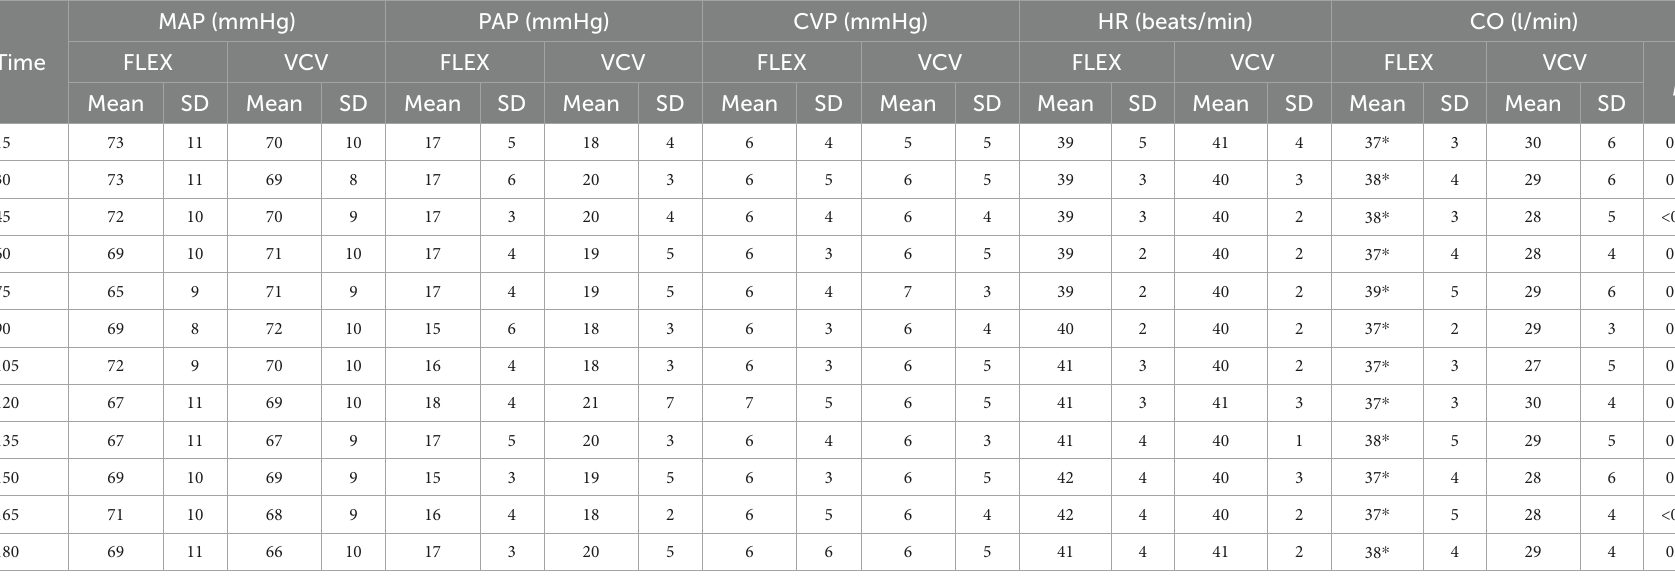
TABLE 2 Mean and standard deviation (SD) of mean arterial blood pressure (MAP), pulmonary artery pressure (PAP), central venous pressure (CVP), heart rate (HR) and cardiac output (CO) of six horses ventilated either with FLEX or conventional volume controlled ventilation (VCV) for 180 min after PEEP-titration alveolar recruitment; time point 0 min is set at after PEEP